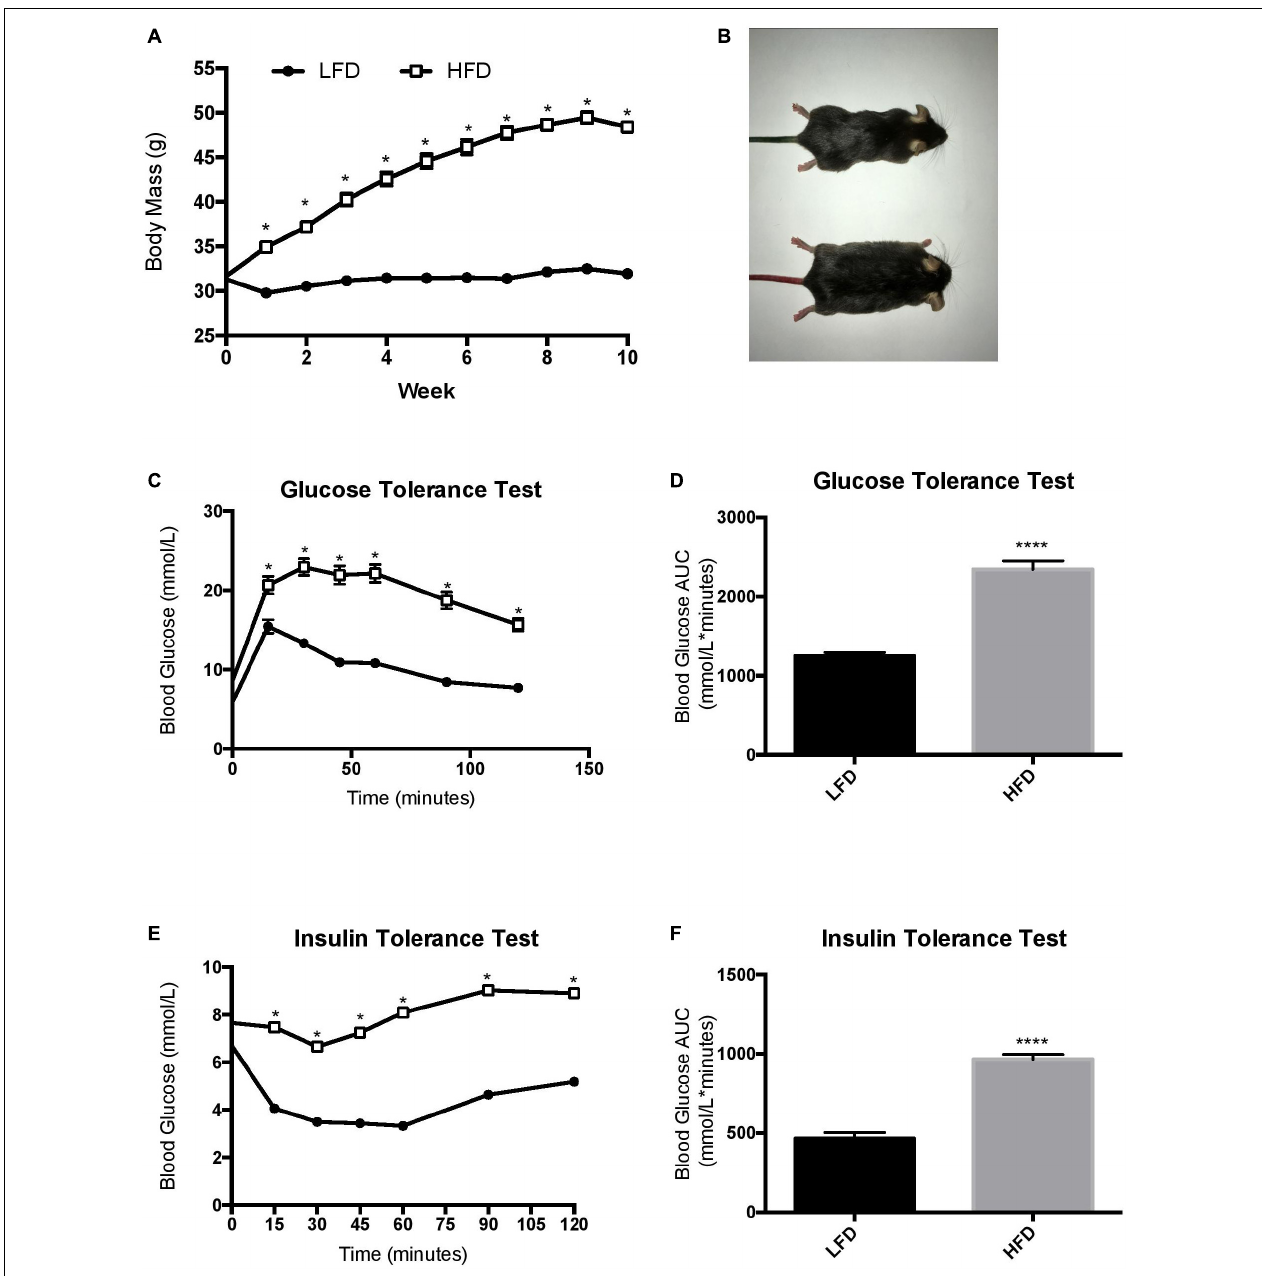
FIGURE 2 | Changes in body mass throughout the duration of the study and endpoint glucose homeostasis. (A) LFD, animals were maintained on a low-fat diet while they aged for 10 weeks from 16 weeks of age; HFD, animals were maintained on a high fat/obesogenic diet for 10 weeks from 16 weeks of age. HFD impairs glucose and insulin tolerance. (B) Visual representation of mice. (C) Glucose tolerance test, (D) Glucose tolerance test represented as area under the curve, (E) Insulin tolerance test, (F) insulin tolerance test represented as area under the curve. Values are represented as mean ± SEM. Significance indicated by ∗ p < 0.05 compared to LFD. ∗∗∗∗ p < 0.00001 compared to LFD. TABLE 1 | Body and tissue mass post-10-week intervention. Body Mass